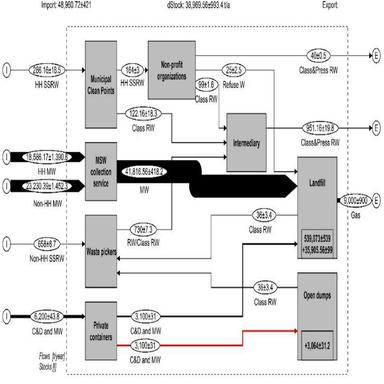
Results of general flows of the system, presented with STAN. In red, waste disposed incorrectly. RW ¼ Recycling waste; Class RW ¼ Classified recycling waste; Class&Press RW ¼ Classified and pressed recycling waste; C&D ¼ Construction and demolition waste; MW ¼ Mixed waste.. (For interpretation of the references to colour in this figure legend, the reader is referred to the Web version of this article.)